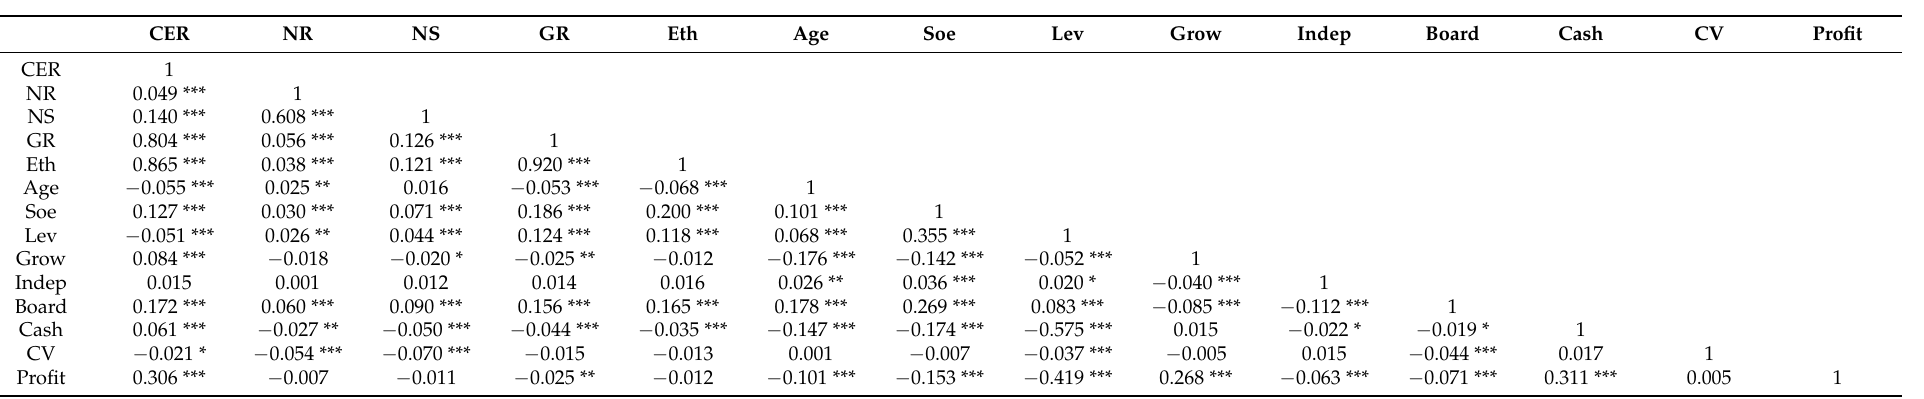
Table 3. Pearson correlation